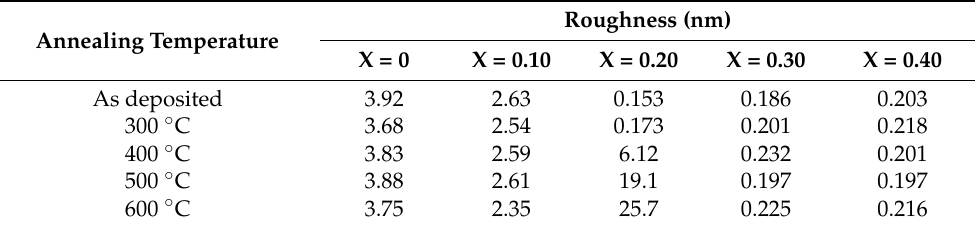
Table 1. The roughness values of the Hf 1 − x Si x O 2 nanocomposites coatings annealed at different